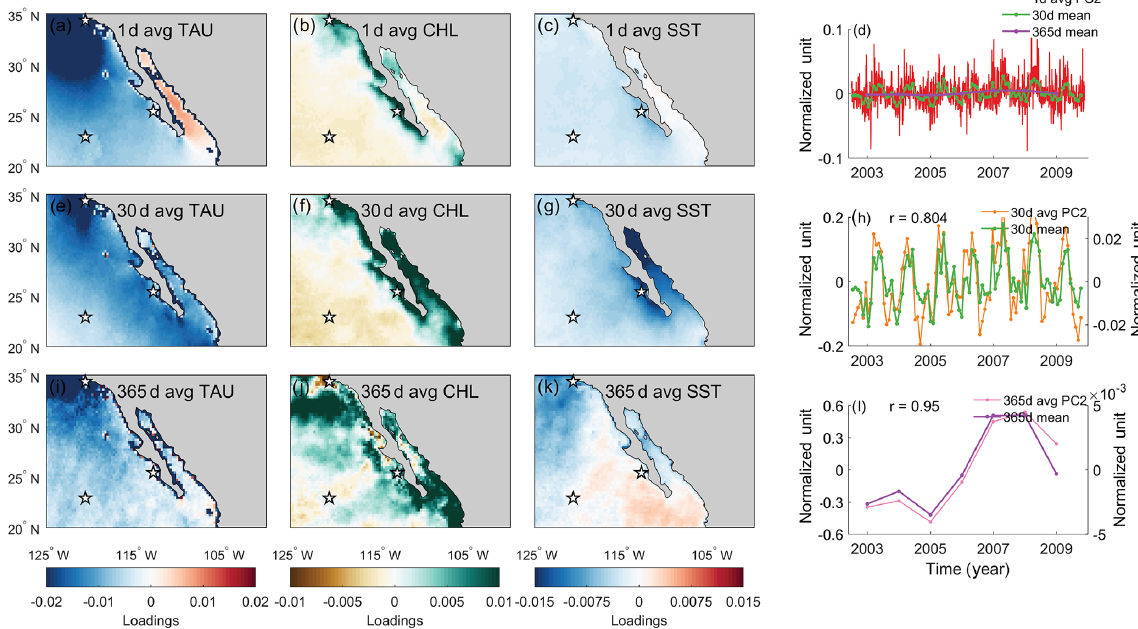
Figure 6. EEOF2 spatial and temporal patterns of TAU, CHL, and SST using (a–d) daily, (e–h) 30d averaged, and (i–l) 365d averaged data. Stars in the spatial pattern plots indicate locations where the differences were taken to compute cross-shore and meridional gradients. 30d mean (green) and 365d mean (purple) time series were derived from averaging 1d average PC2. The correlation coefficient indicates how well the time mean of 1d average PC tracks the PC of the time-averaged data.